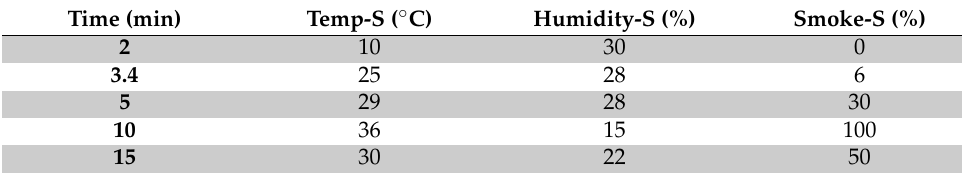
Table 2. Experiment No 1.